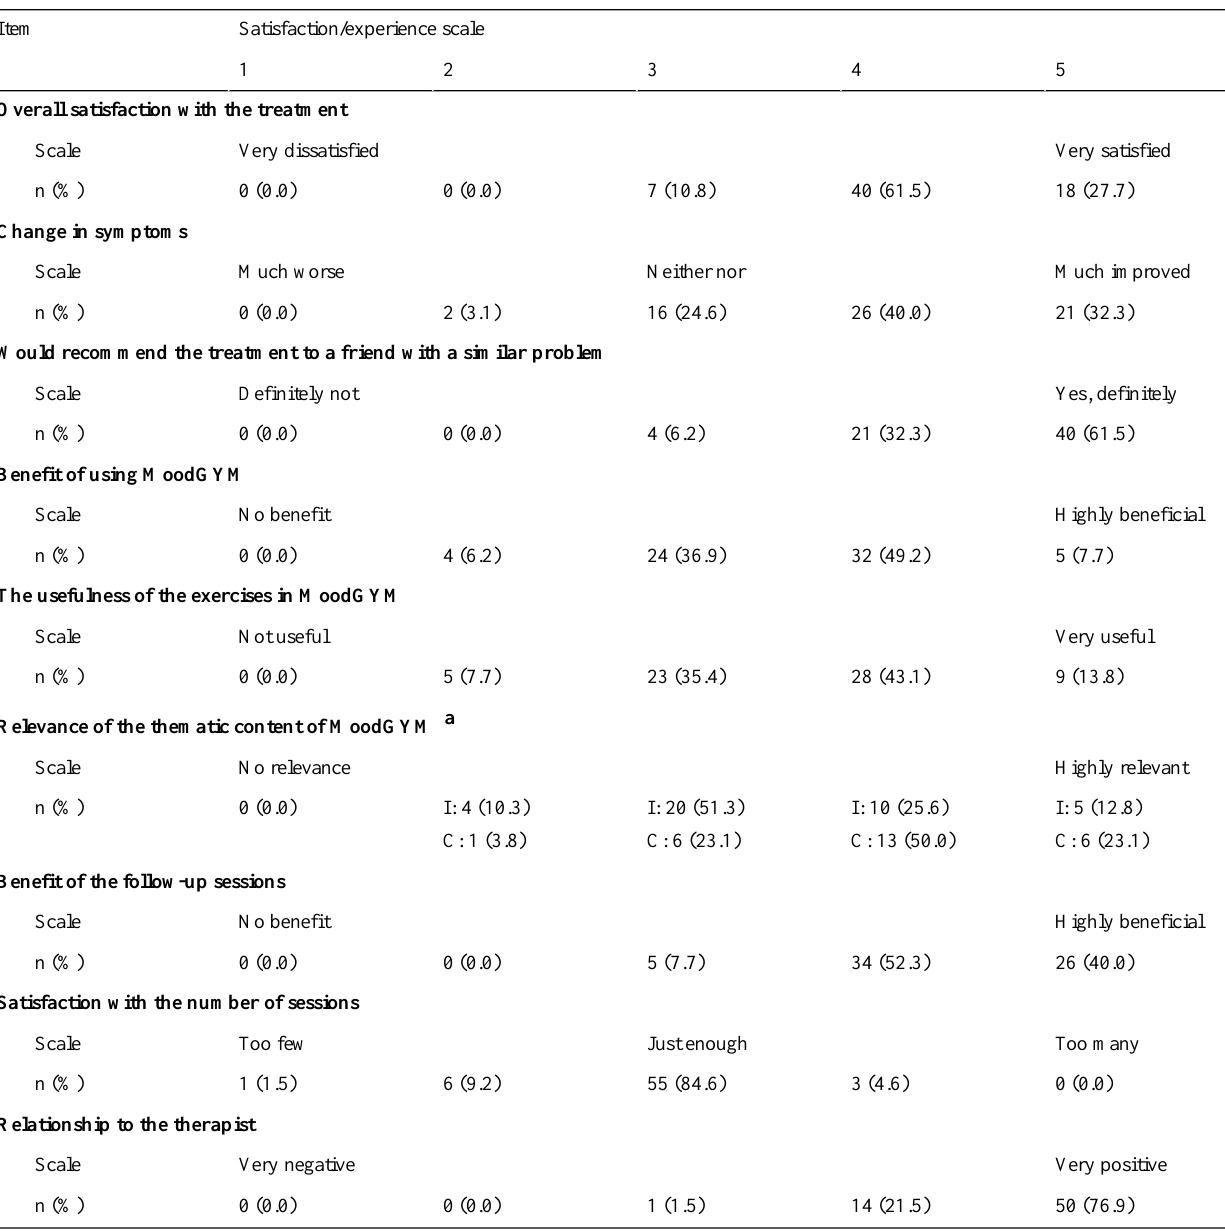
Table 4. Response frequencies regarding satisfaction and experiences with the treatment